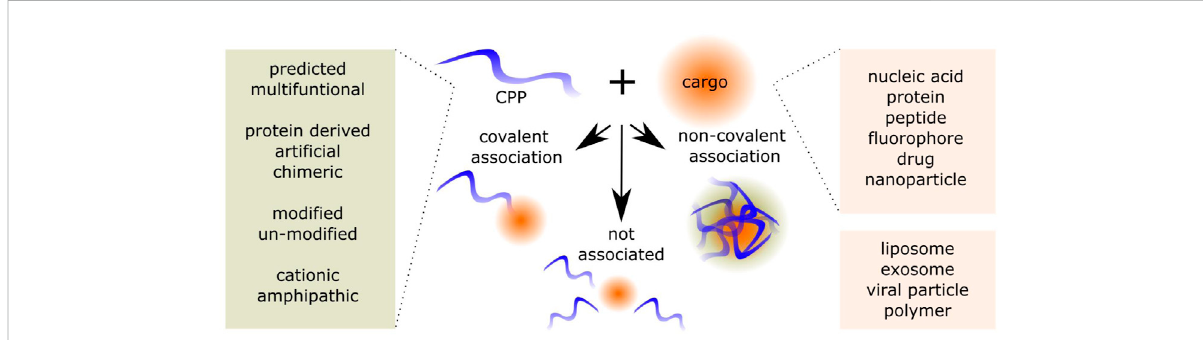
FIGURE 1 Cell-penetrating peptide (CPP) and cargo associations. The CPPs include predicted and already con fi rmed CPPs derived from proteins, chimeric andofarti fi cialorigin.TheCPPs areaversatilefamily ofchemicaldeliveryvectors,where cationic,primary andsecondaryamphipathic, and even negatively charged peptides are represented. The CPPs may be modi fi ed to include non-proteogenic amino acid residues, addition of PEG or fatty acid residues. The cargos CPPs can be associated include a variety of moieties, additionally, CPPs can be used to enhance the internalization of NPs. The associations are the covalent association of CPP and cargo, non-covalent associations, or the CPP can be added into the mixes without it associating with the